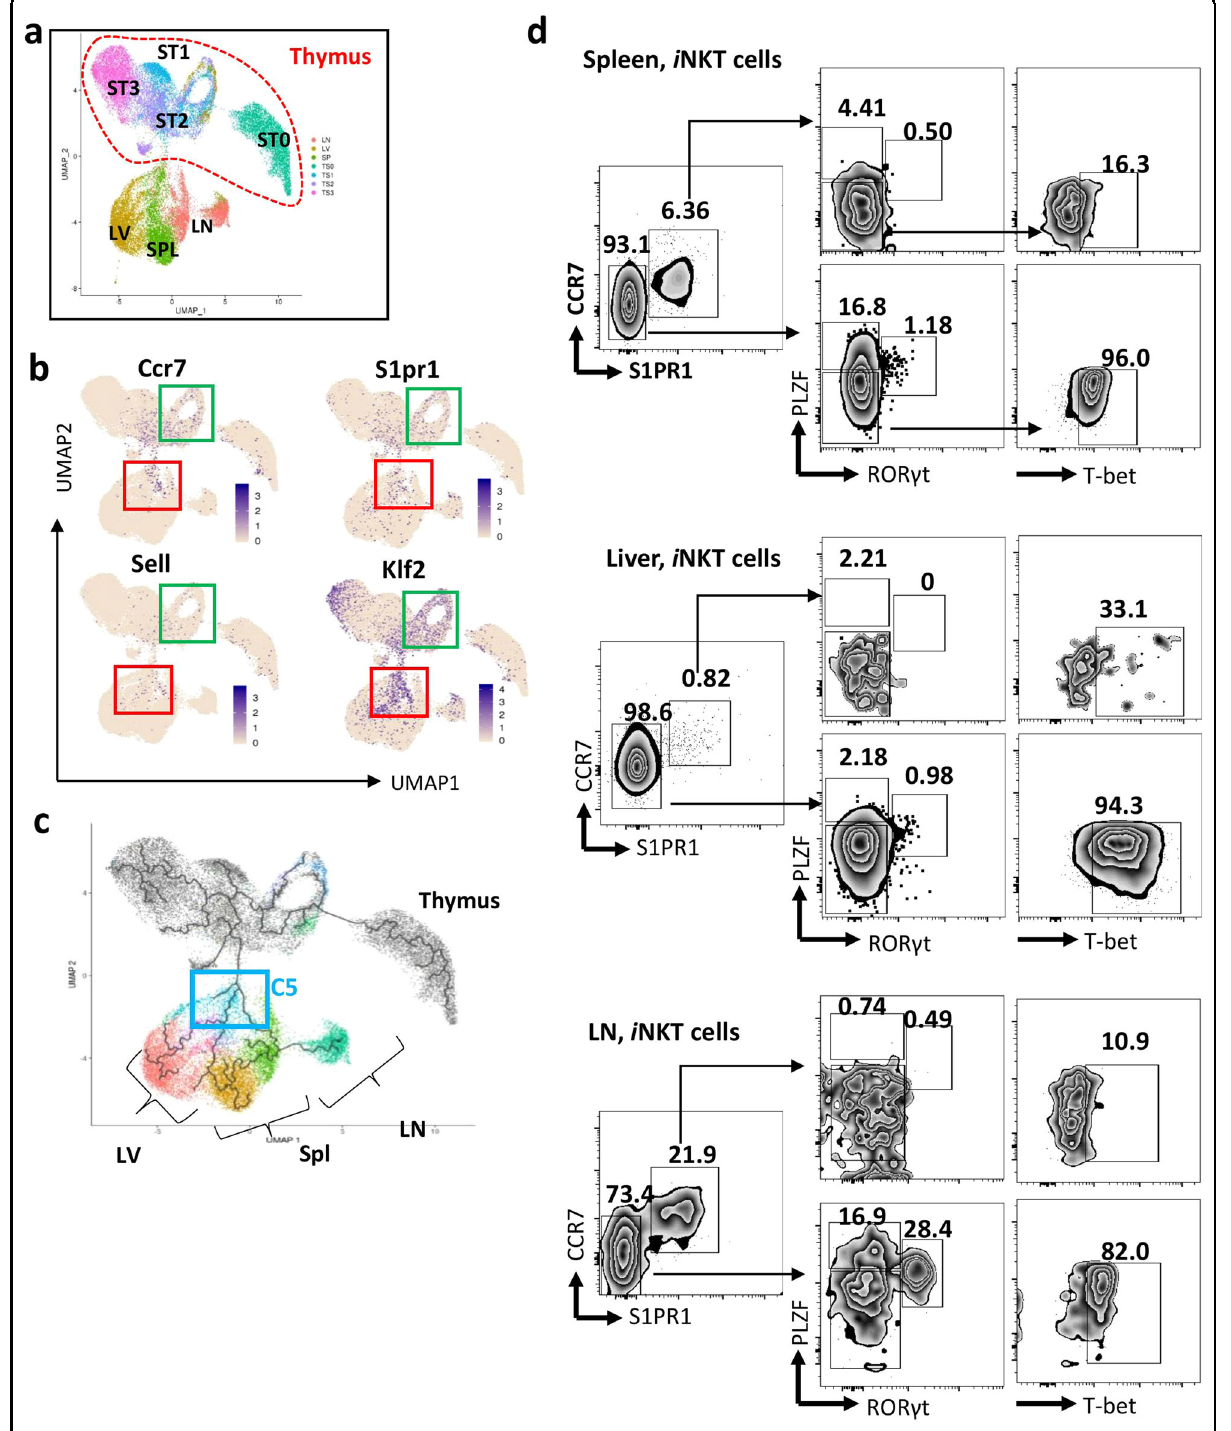
Fig. 4 Homing signatures pro fi les of i NKT cells from peripheral organs. a UMAP plots showing relationships between i NKT cells from different peripheral organs. b UMAP plots showing multiple homing markers expression in integrated thymic and peripheral i NKT cells. c The ordering of i NKT cells along pseudotime in a state-space de fi ned by Monocle 3. Each color represents an i NKT cluster. d Flow cytometry showing RTEs (CCR7 + S1PR1 + ) and non-RTEs (CCR7 – S1PR1 − ) from indicated organs. i NKT1(PLZF lo T-bet hi ), i NKT2 (PLZF hi ROR γ t − ), and i NKT17(PLZF int ROR γ t + ) cells in RTEs and non-RTEs from indicated